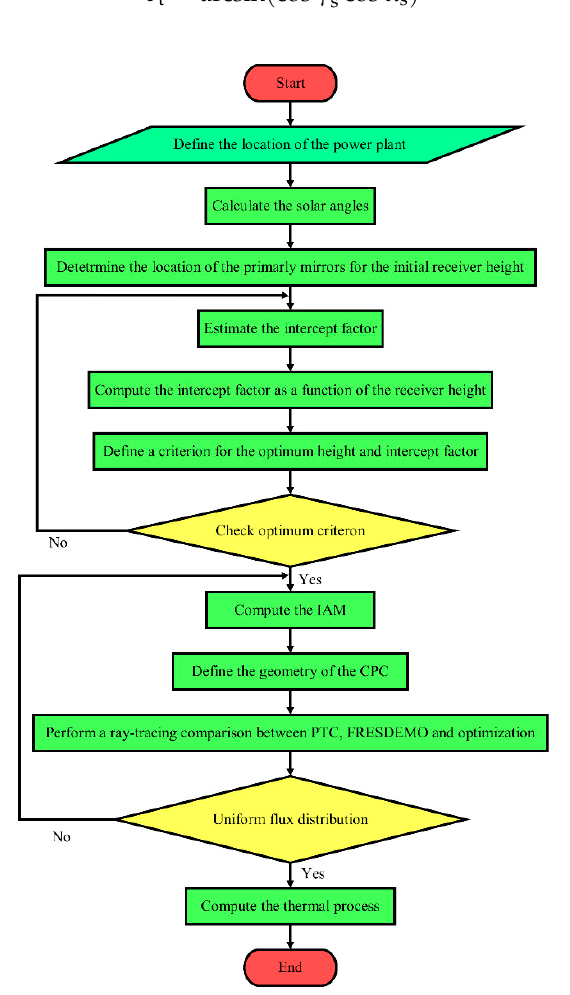
Figure 2. Methodology for the optimization of the linear Fresnel reflector (LFR) field.